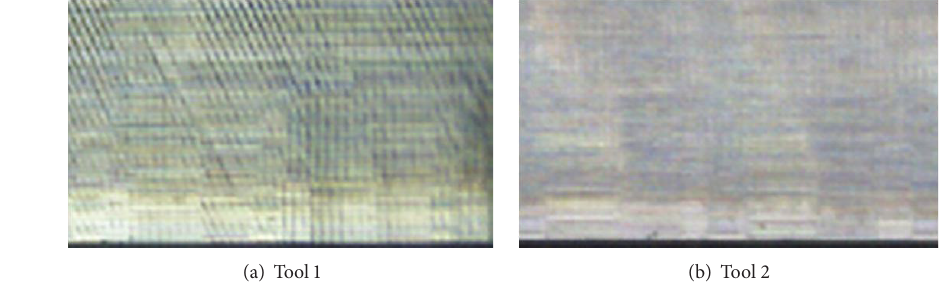
Figure 13: The comparisons of surface quality.